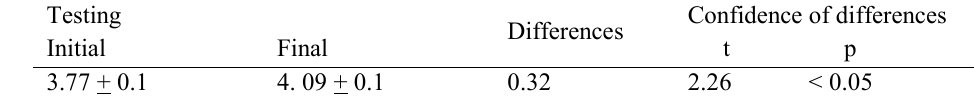
Table 4. Indicators of level of interest (points) to trainings in students of control and experimental groups at the end of pedagogic experiment